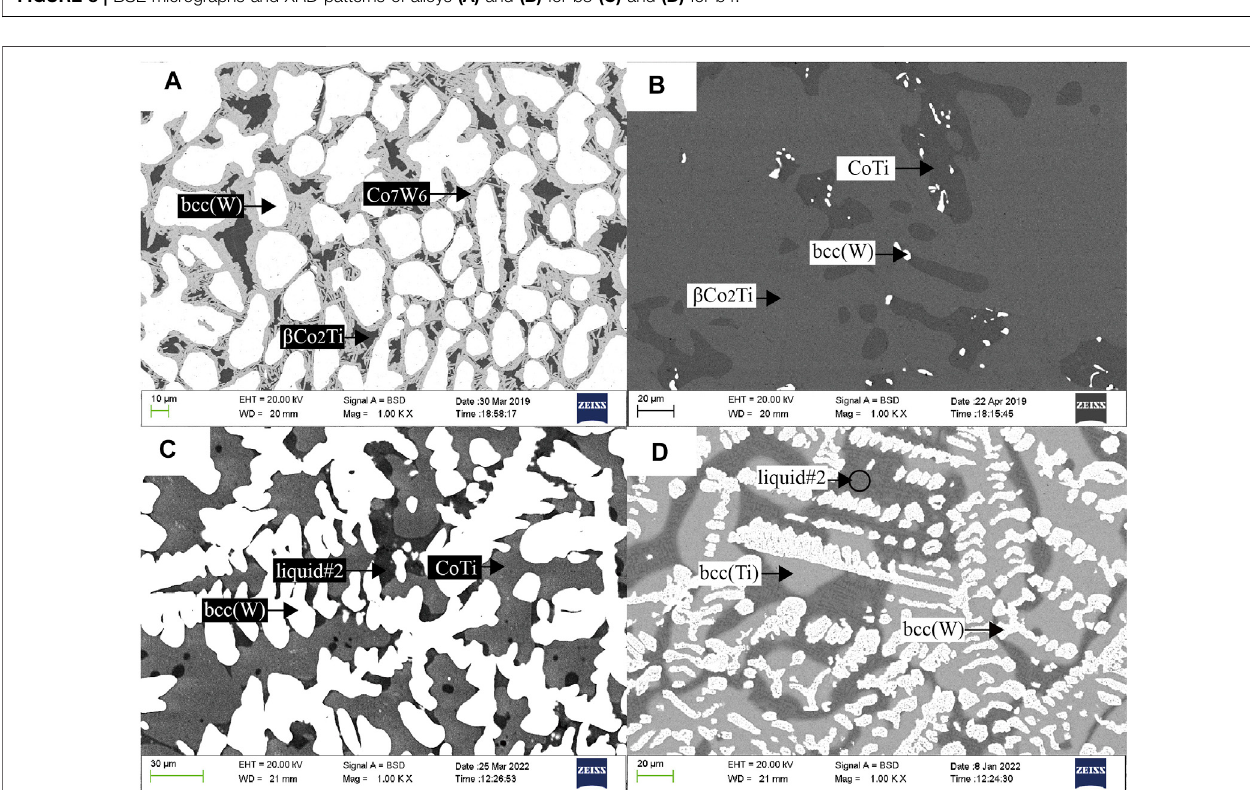
FIGURE 9 | BSE micrographs of alloys (A) for b5 (B) for b6 (C) for b7 (D) for b8.